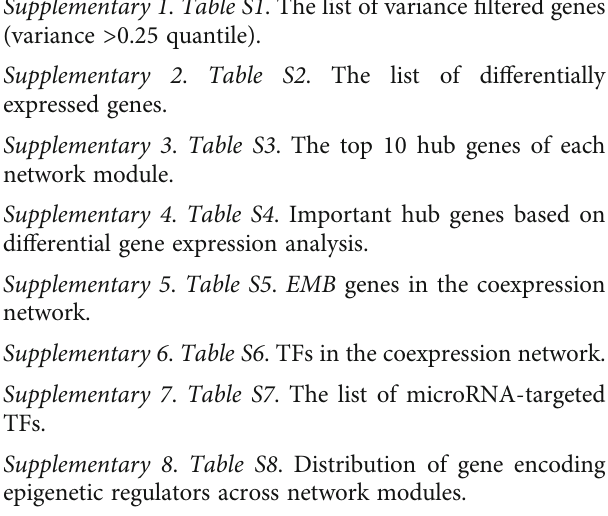
Supplementary 1 . Table S1 . The list of variance fi ltered genes (variance > 0.25 quantile). Supplementary 2 . Table S2 . The list of di ff erentially expressed genes. Supplementary 3 . Table S3 . The top 10 hub genes of each network module. Supplementary 4 . Table S4 . Important hub genes based on di ff erential gene expression analysis. Supplementary 5 . Table S5 . EMB genes in the coexpression network. Supplementary 6 . Table S6 . TFs in the coexpression network. Supplementary 7 . Table S7 . The list of microRNA-targeted TFs. Supplementary 8 . Table S8 . Distribution of gene encoding epigenetic regulators across network